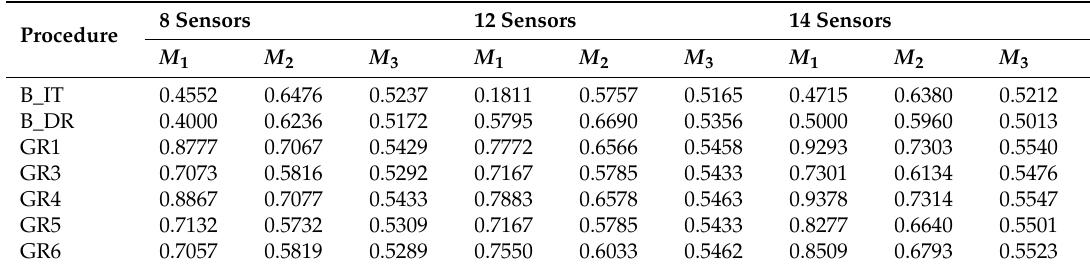
Table 4. Performance indicator values.